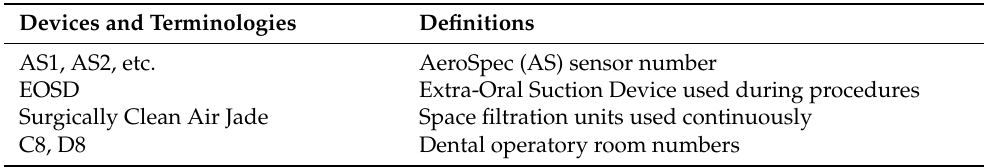
Table 1. Explanation of the devices and variables used in the study.